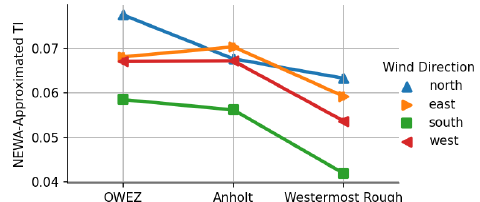
Figure 9. Average ambient turbulence intensity (TI) based on New European Wind Atlas (https://map.neweuropeanwindatlas.eu/, last access: 12 February 2022) mesoscale simulations for the three Eu- ropean offshore wind farms. Note that TI is approximated from tur- bulent kinetic energy using Eq.